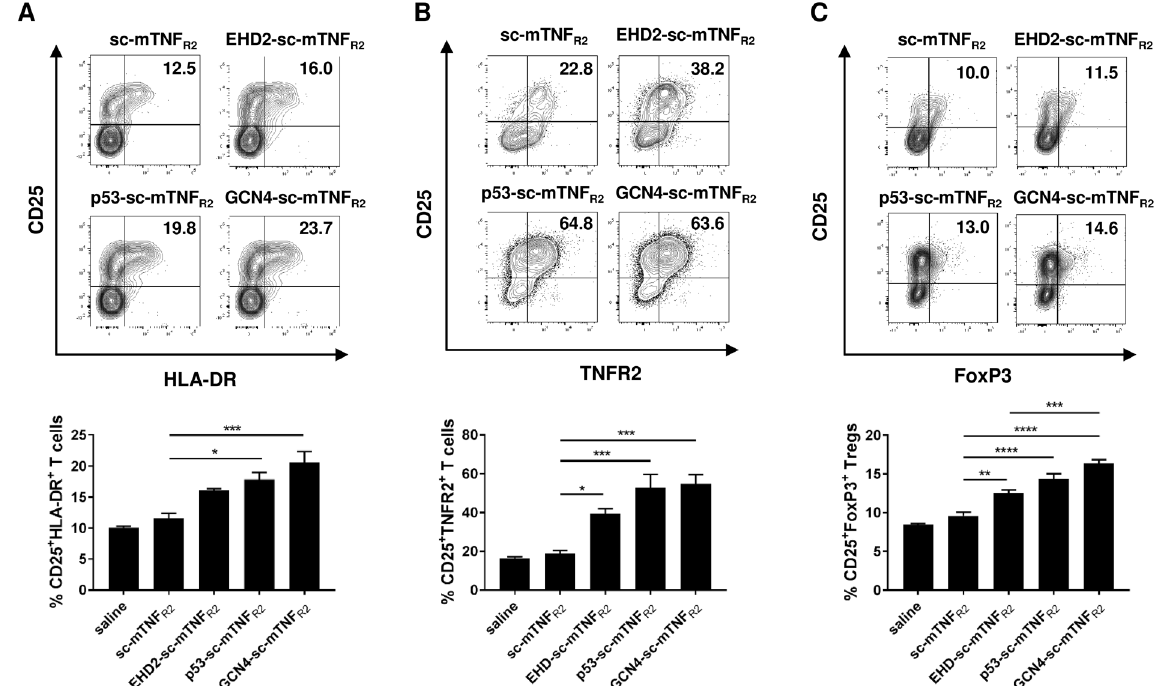
Figure 6. Dodecameric TNF muteins most potently induce T cell activation and Treg expansion ( A ) CD3 + T cells were isolated from human peripheral blood mononuclear cells (PBMCs) via magnetic separation. T cells were activated using plate-bound anti-CD3 (1 µ g/ml) and cultivated in presence of interleukin 2 (IL-2, 10 U/ ml) and 0.3 nM of the oligomerized TNF muteins for 4 days. Number of activated CD25 + HLA-DR + T cells was determined by flow cytometry. Shown is a representative donor (upper panel). Combined data are from three independent donors (n = 3 ± SEM, lower panel) ( B , C ) CD3 + T cells were isolated from mouse splenocytes. T cells were activated using plate-bound anti-CD3 (5 µ g/ml) and cultivated in presence of interleukin 2 (IL-2, 100 U/ml) and 0.3 nM of the oligomerized TNF muteins for 4 days. Number of ( B ) activated CD25 + TNFR2 + T cells and ( C ) CD25 + FoxP3 + Tregs was determined by flow cytometry. Shown is a representative donor (lower panel). Combined data are from three independent experiments (n = 3 ± SEM, lower